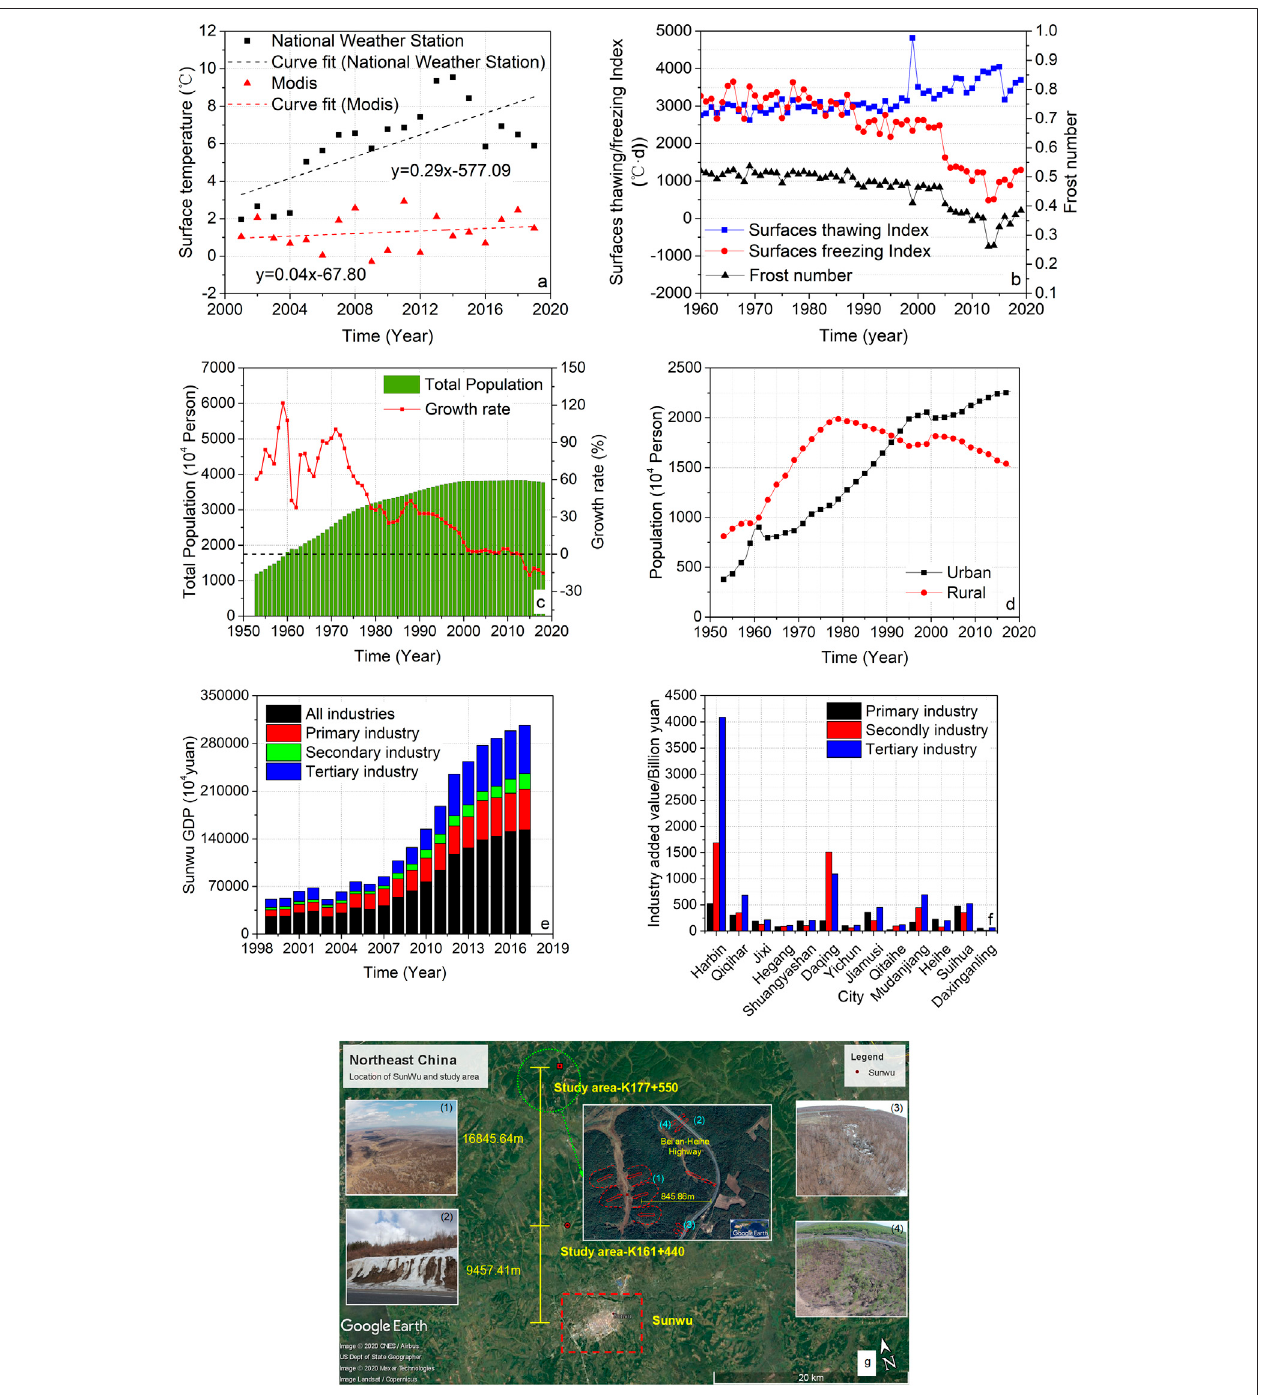
FIGURE1 | Permafrost degradation, population, urbanization, and landslide distribution near the study area. (A) Surfacetemperature changes of theSunwu area, includingthedataofSunwunationalweatherstationandMODISdata(Guoetal.,2020;Shanetal.,2020b). (B) Changesofsurfacefreezing,thawingindex,andfreezing number from 1960 to 2019. The calculation method is shown in reference (Guo et al., 2020; Shan et al., 2020b). (C) Population changes and the growth rate of Heilongjiang Province, China. (D) Changes of the urban population and rural population in Heilongjiang Province. (E) GDP of different industries in Sunwu County (Primary industry: agriculture, forestry, animal husbandry, fi shery, etc., Secondary industry: mining, manufacturing, electricity, gas and water production and supply, construction,etc.,Tertiaryindustry:transportation,storageandpostalindustry,informationtransmission,computerserviceandsoftwareindustry,etc.). (F) Addedvalue of different industries in different cities in Heilongjiang Province (Primary industry, Second industry, Tertiary industry). (G) The straight-line distance between Sunwu County and the observation points at K161 + 440 and K177 + 550 in the study area and the pictures of landslides at K177 + 550 [landslides (1), (2), (3), (4)].